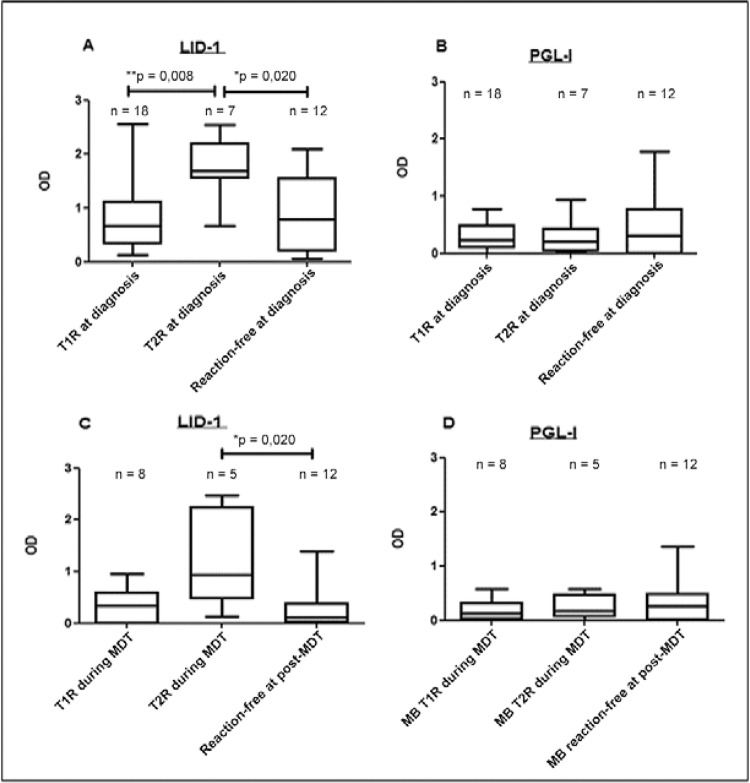
antibody levels against: leprosy Infectious Disease Research Institute
diagnostic-1 (LID-1) (A), phenolic glycolipid I (PGL-I) (B) in multibacillary
(MB) patients who presented at the time of initial diagnosis with either type 1
reaction (T1R) (n = 18), type 2 reaction (T2R) (n = 7) or no reaction (n = 12).
Antibody responses to LID-1 (C) and to PGL-I (D) in MB patients who presented
during multidrug therapy (MDT) with either T1R (n = 8), T2R (n = 5) or no
reaction (n = 12). The boxes represent the 25th and 75th percentiles for each
group, while lines in the box mark the median optical density (OD). Asterisks
mean p < 0.05.